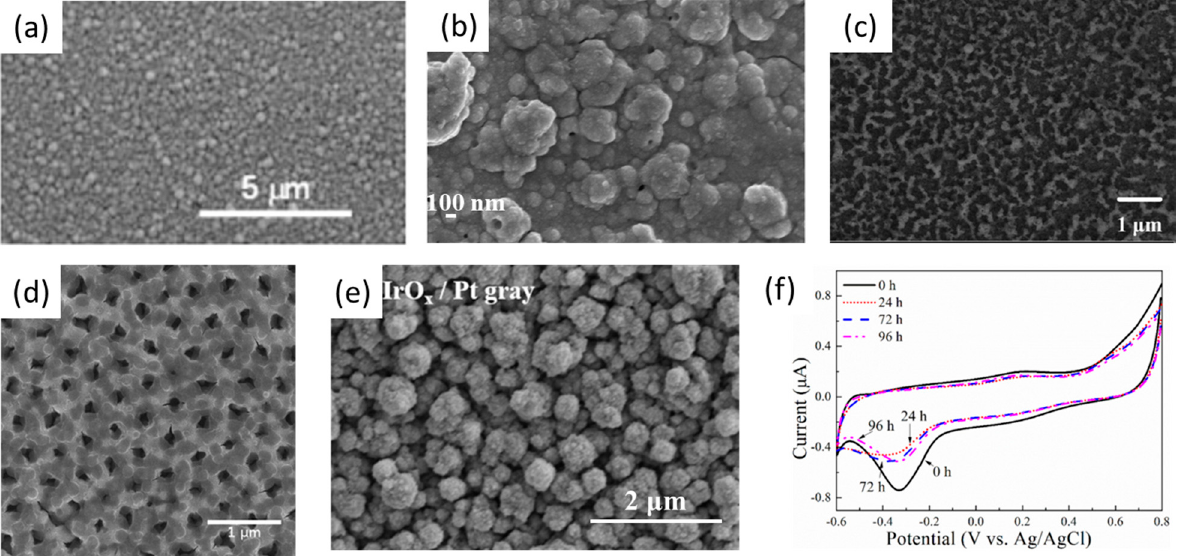
Figure 3. SEM image of ( a ) SIROF, ( b ) EIROF, ( c ) AIROF, ( d ) nanoporous AIROFs, and ( e ) IrO x /Pt gray. ( f ) Cyclic voltammograms of an IrO x /Pt gray-coated microelectrode before and after 24 h, 72 h and 96 h of continuous stimulations. ( a ) is reproduced with permission from [85], Copyright 2009, Wiley Online Library. ( b ) is reproduced with permission from [97], Copyright 2009, Elsevier. ( c ) is reproduced with permission from [107], Copyright 2014, Elsevier. ( d ) is reproduced with permission from [105], Copyright 2010, Elsevier. ( e , f ) are reproduced with permission from [106], Copyright 2017, Elsevier.